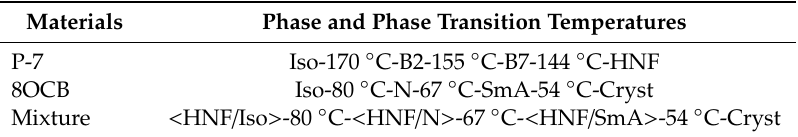
Table 1. Phase-transition temperatures of P-7, 8OCB, and the